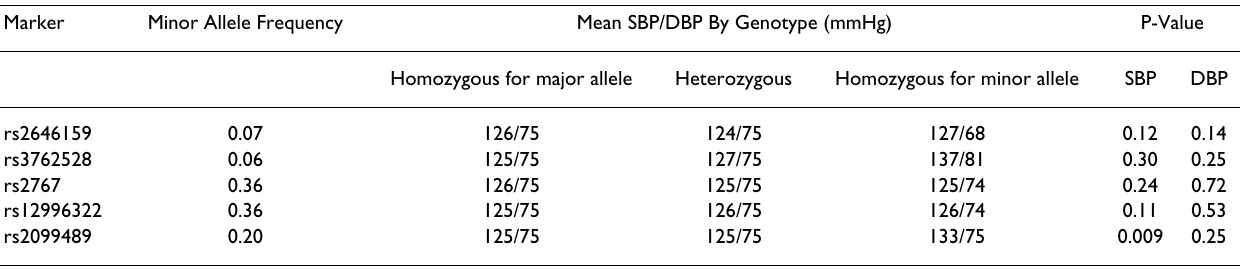
Table 3: Replication of association in a sample of Caucasians enrolled in the FHS. Marker Minor Allele Frequency Mean SBP/DBP By Genotype